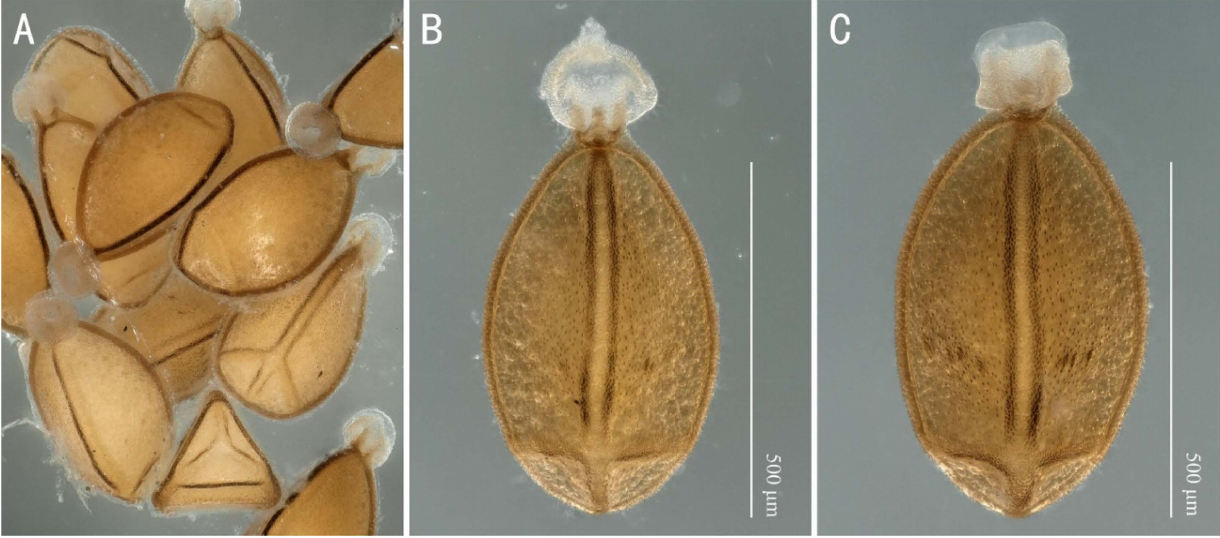
Figure 12. Filchneria zhouchangfai from Anhui, egg. ( A ) multiple eggs with different directions; ( B , C ) ma‑ ture egg with few 1–2 or 4–5